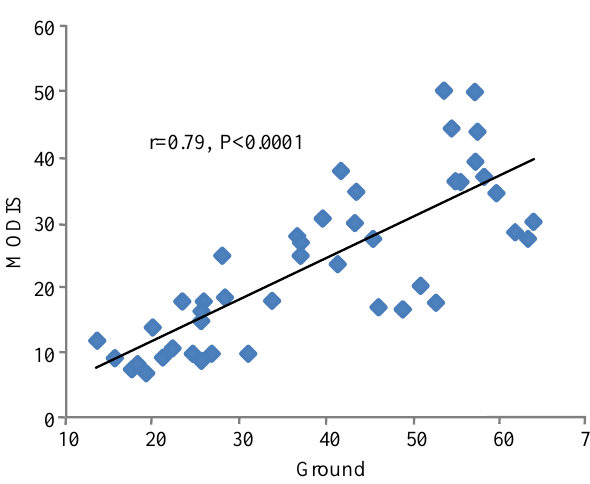
Figure 4. A linear comparison of MODIS GPP and observed gross primary production (gCm − 2 × d − 1 ) at the eddy flux tower site in Qianyanzhou, Jiangxi province. MODIS data are positively related to ground data ( r = 0 . 79, P < 0 . 0001, n = 25).